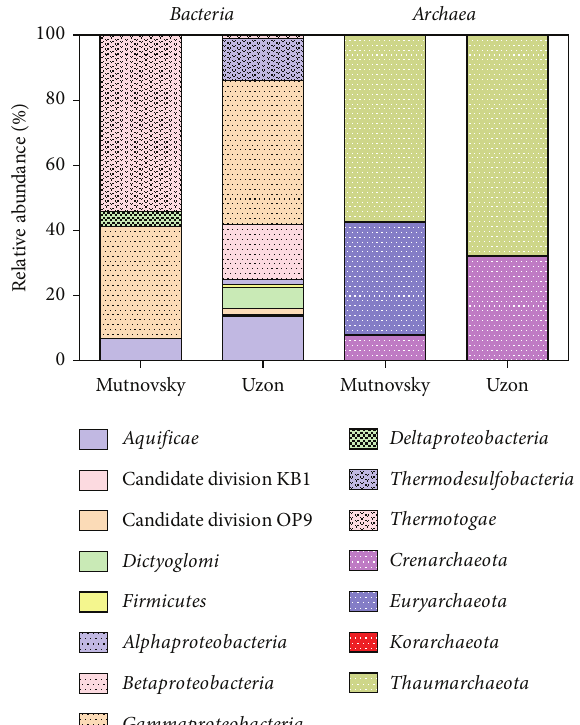
Figure 1: Relative sequence abundances of different archaeal and bacterial phyla and proteobacterial